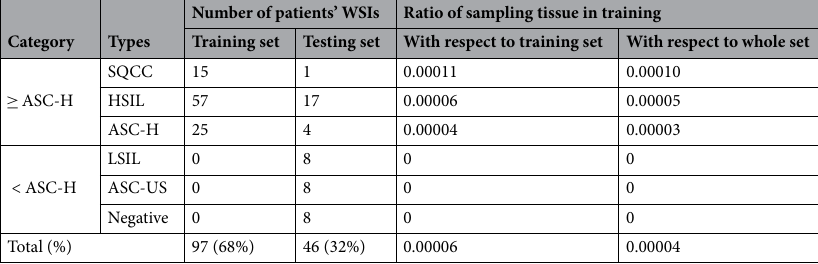
Table 1. Data distribution and ratio of sampling tissue for AI training.